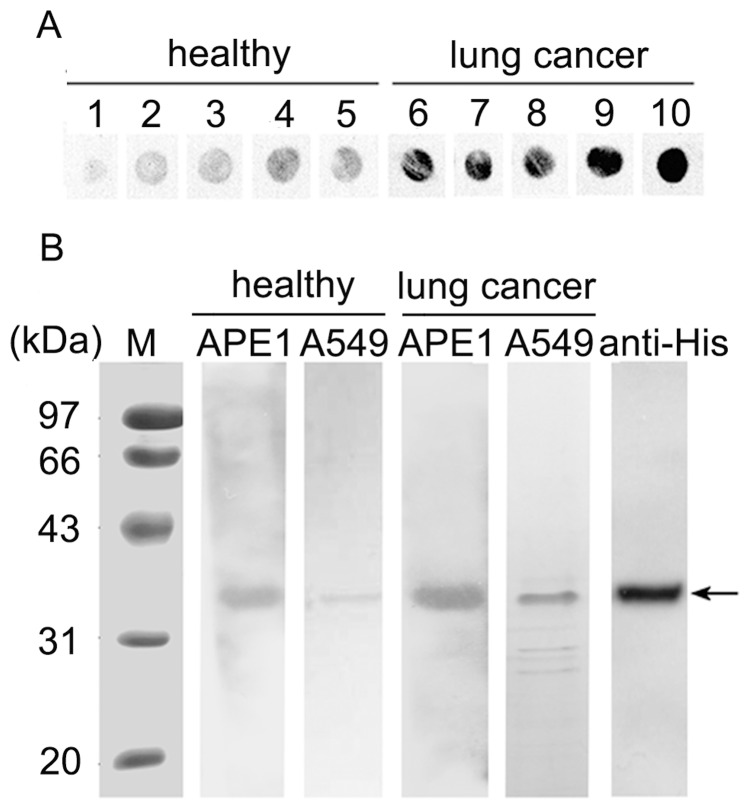
Dot blot and Western blot for identifying serum APE1-AAbs.A, Representative results of detection of sera APE1-AAbs by dot blot assay. Lanes 1∼5: serum of healthy subjects. Lanes 6∼10: serum of NSCLC patients. B, Serum APE1-AAbs of healthy and NSCLC patients were detected by Western blot analysis. Lane M, protein molecular weight markers; APE1, APE1 fusion protein with His tag; A549, total cell protein extracted from A549 cells; Anti-His, APE1 fusion protein detected by His antibody.